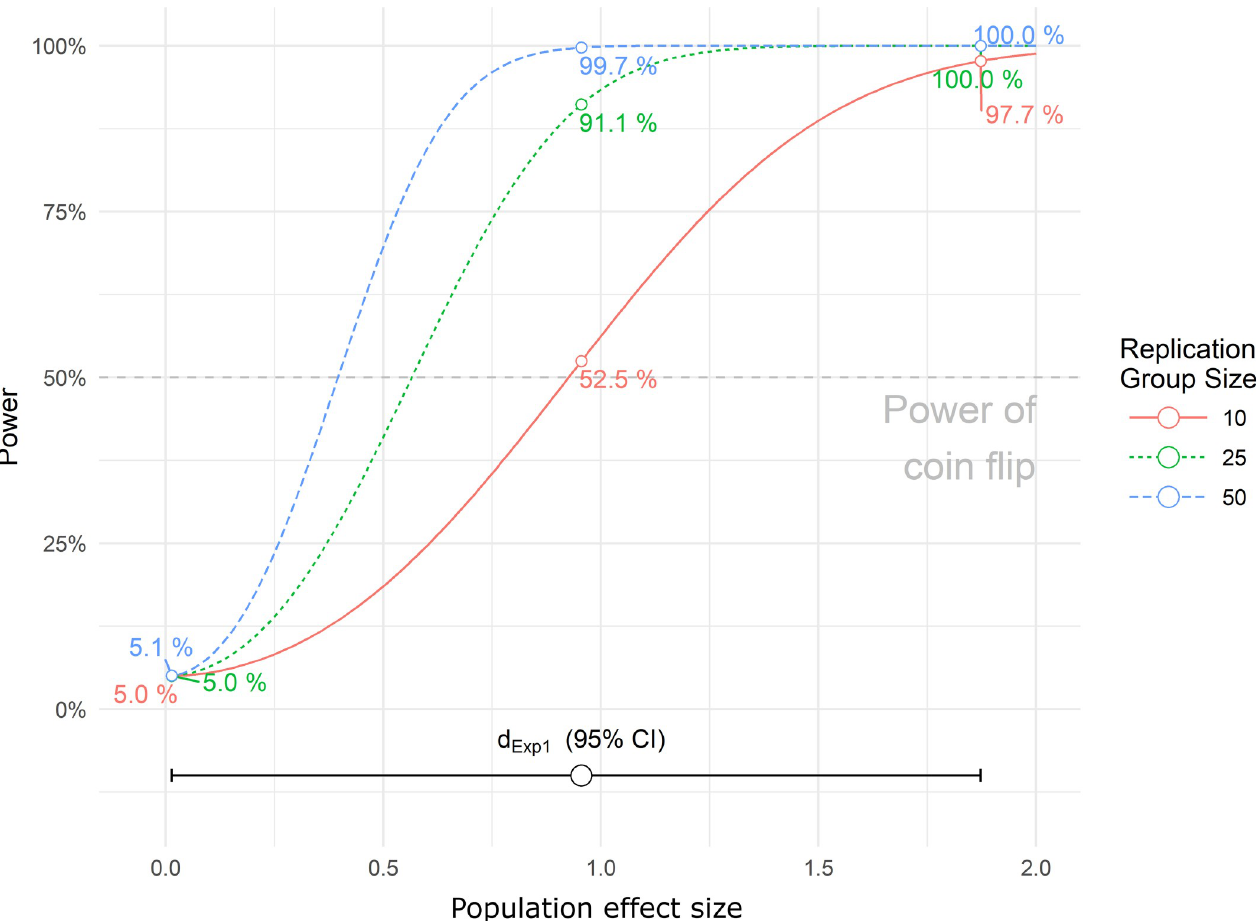
Fig 1. Power of replication experiment depending on the expected effect size and sample size. Colored numerical values refer to our original experiment. Data of this figure can be found in S1 Data, and the figure can be explored further under s-quest.bihealth.org/power_replication/.